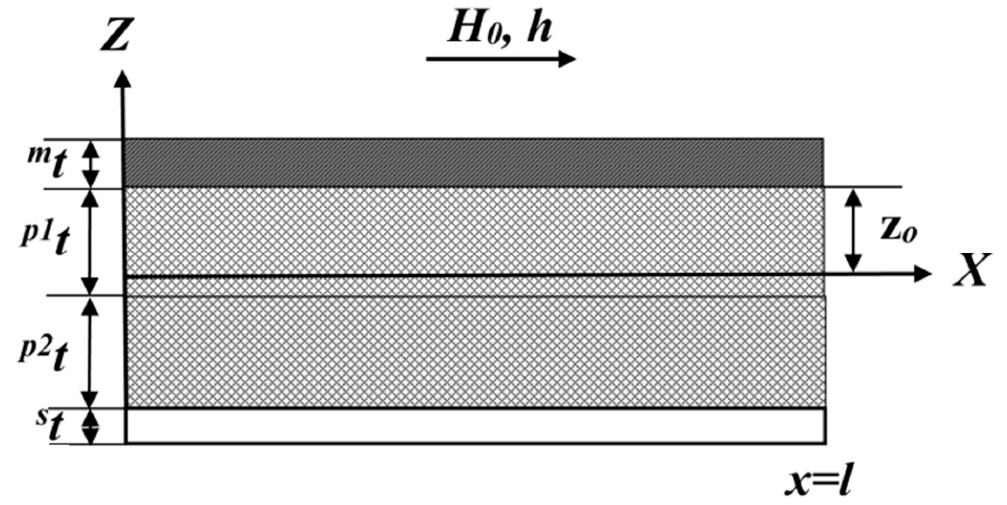
Figure 1. The asymmetrical ME structures.